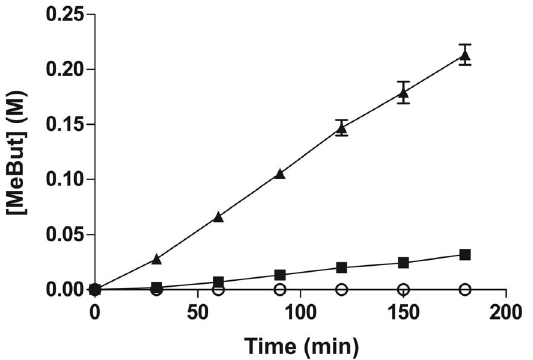
Figure 1. Effect of whole-cell biocatalyst (WCB) pretreatment on ester synthesis activity. Ten milligrams of each biocatalyst was used to convert 1 mmol of glyceryl tributyrate to methyl butyrate using 4 molar equivalents of methanol and 5% (w/w) water in tert- butanol over a period of 3 hours at 40 u C. The control strain expressing the empty pET16b vector (open circles), the LipIAF5-2 strain without CTAB pretreatment (closed squares) and the strain with CTAB permeation (closed triangles) were employed. Results are averaged over three independent experiments.